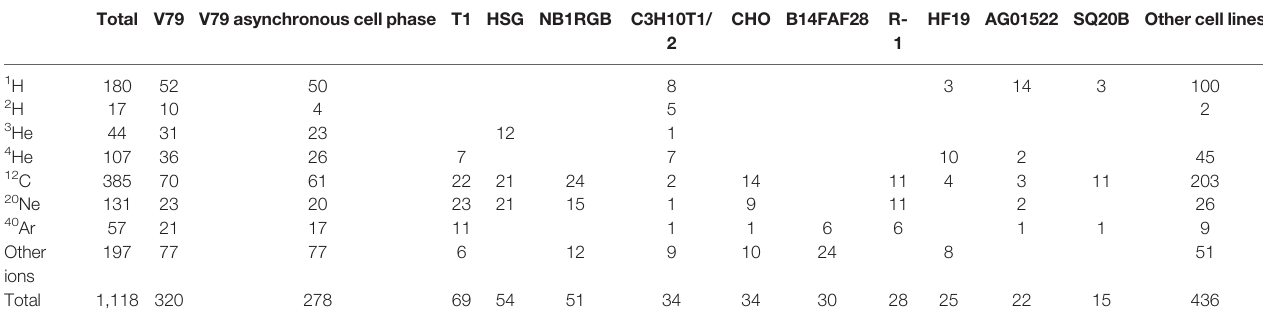
TABLE 1 | The number of experiments compiled in the PIDE project presented for a subset of ions and cell lines with more than 15 sets of